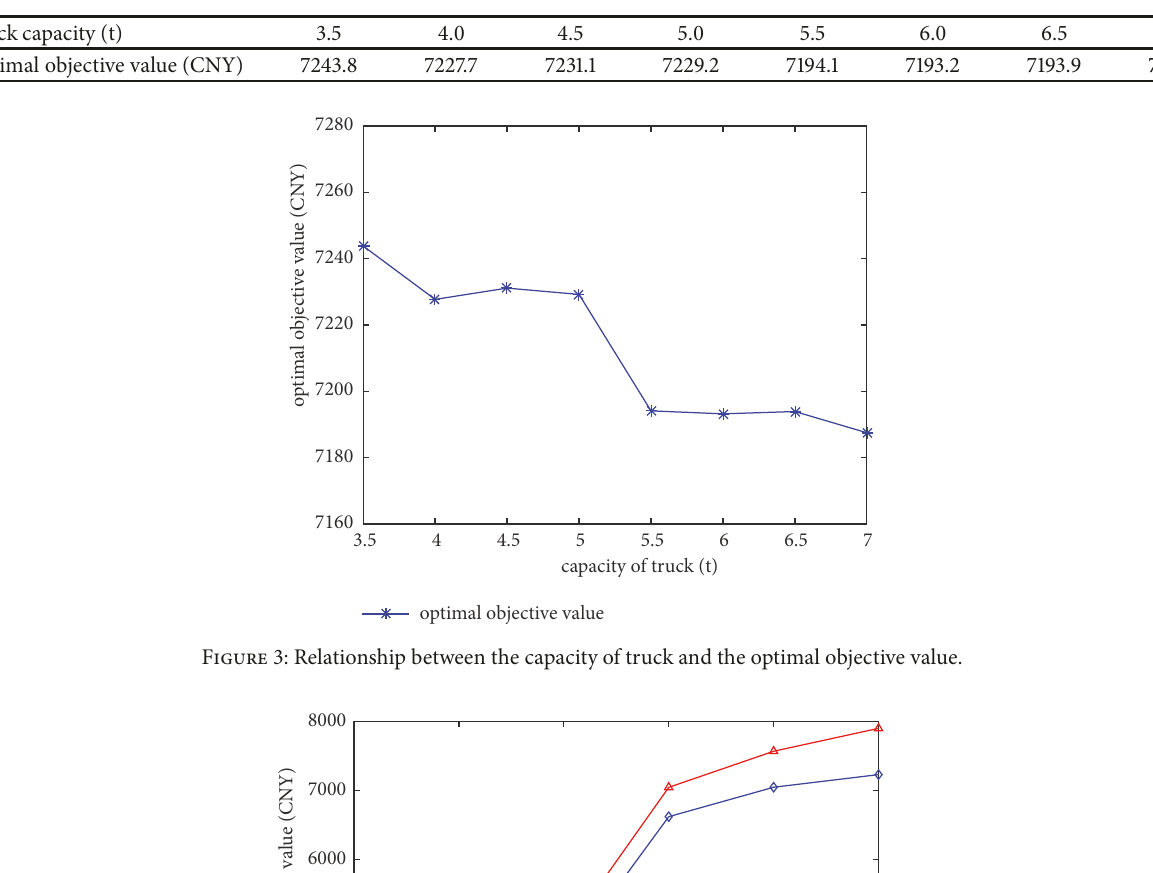
Table 8: Optimal objective value under different truck capacity.